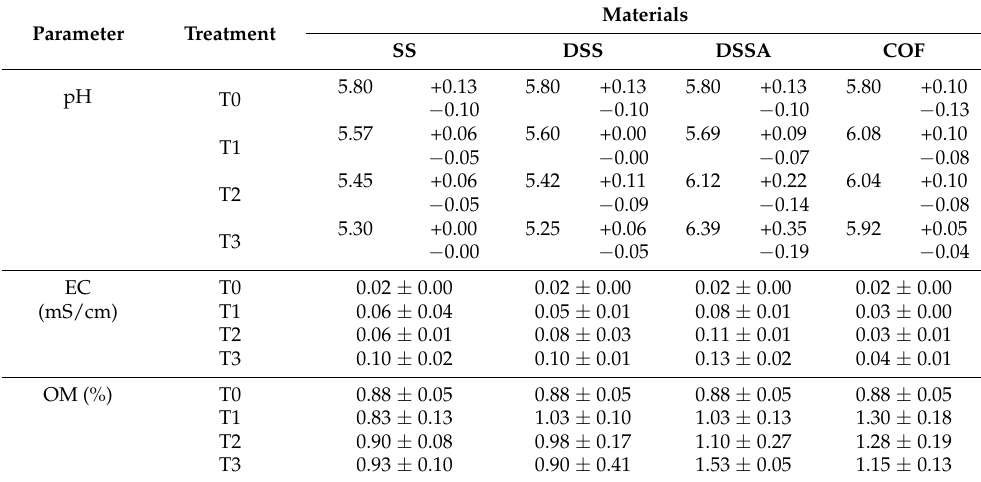
Table 5. pH, EC, and OM of the soil after lettuces harvest, for all treatments and soil amendments (mean values obtained in four replicates of each treatment; mean ± standard